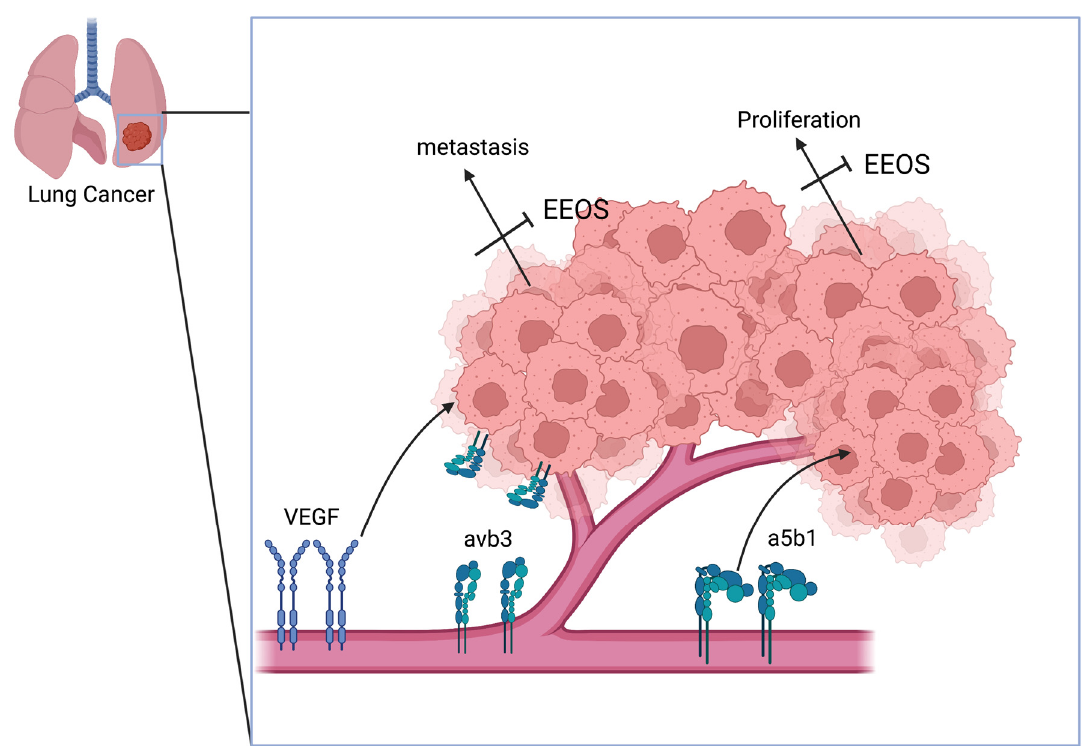
Figure 4. Schematic overview of the mechanism of Ocimum sanctum Linn. ethanolic extract, inhibiting the adhesion, proliferation, and migration of A549 human lung adenocarcinoma, mediated by the downregulation of α v β 3, α 5 β 1, and VEGF. Overall, inhibition by EEOS will mitigate angiogenesis and metastasis of human lung adenocarcinoma cells.